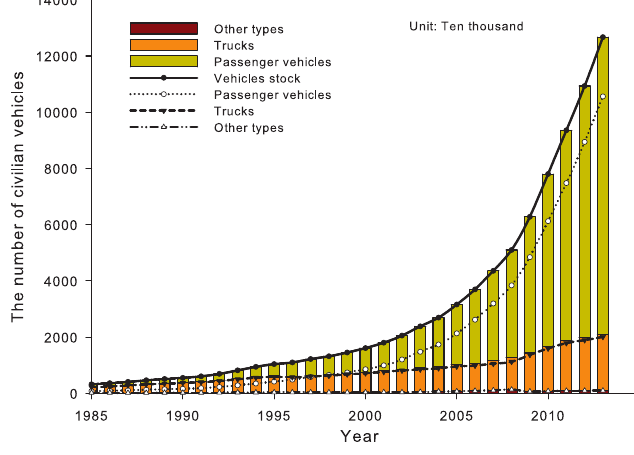
Figure 2. The civil vehicles in China (source: NBSC,